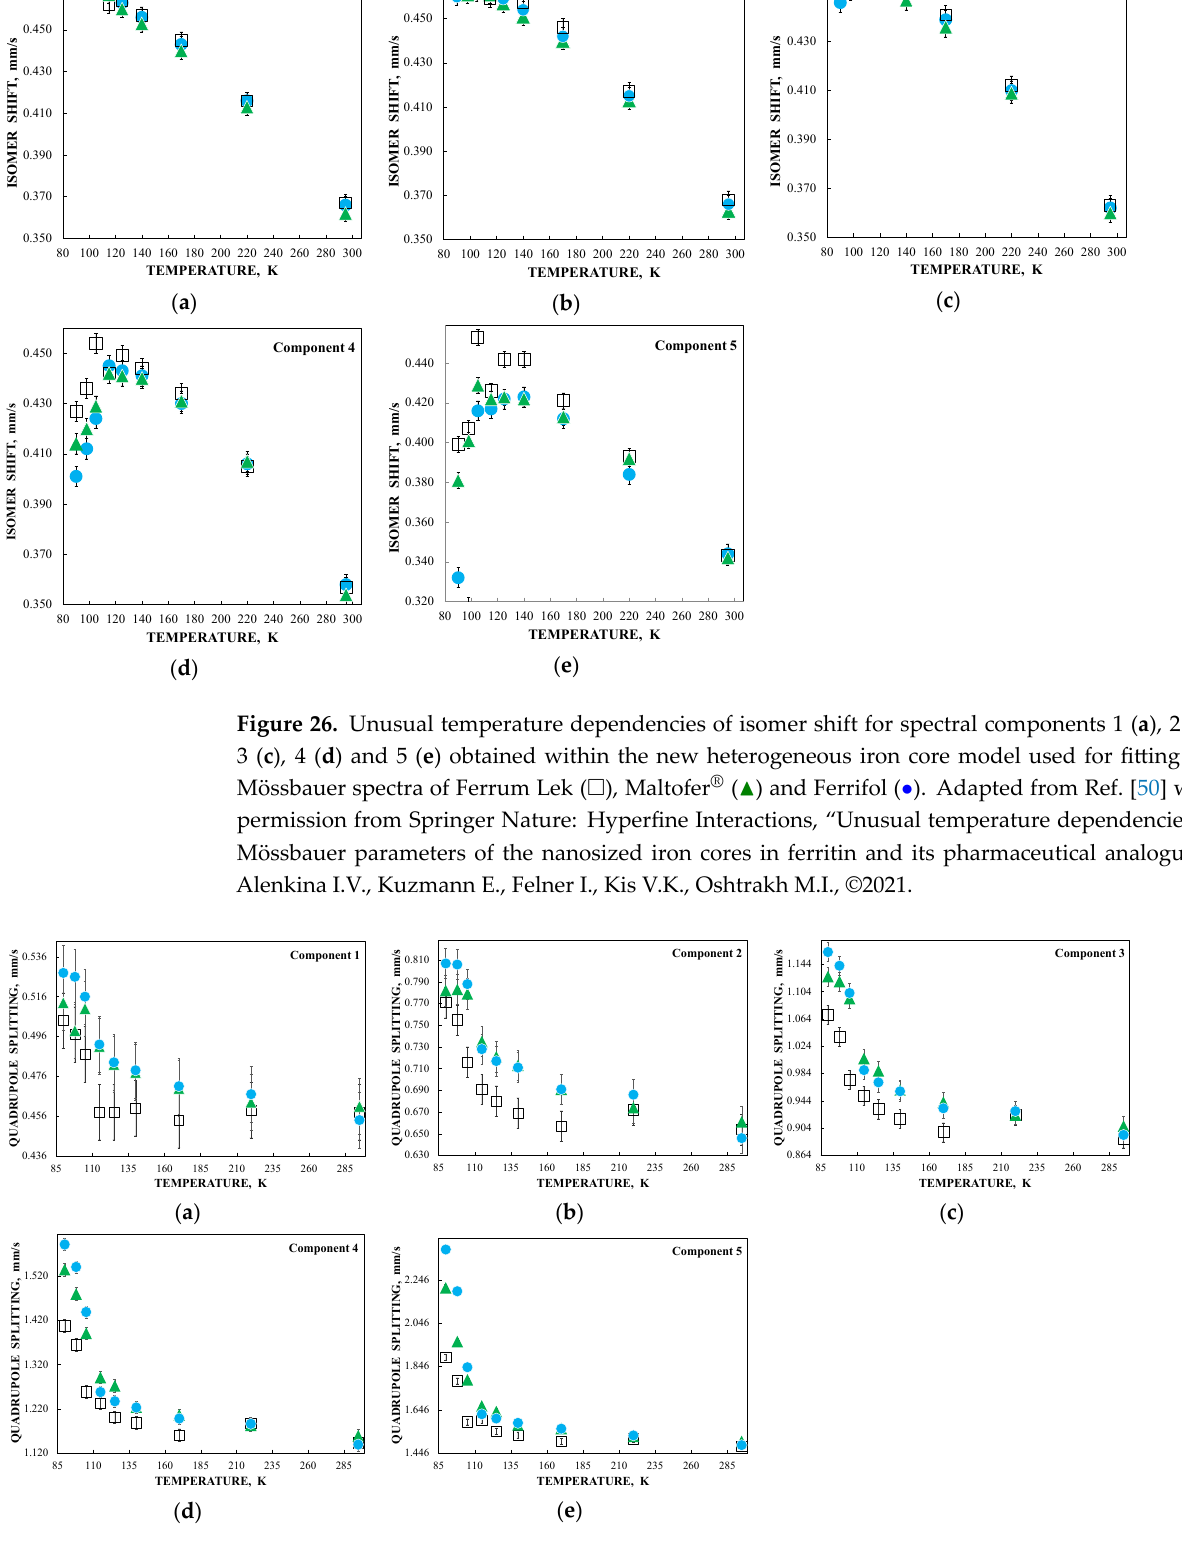
Figure 27. Unusual temperature dependencies of quadrupole splitting for spectral components 1 ( a ), 2 ( b ), 3 ( c ), 4 ( d ) and 5 ( e ) obtained within the new heterogeneous iron core model used for fitting the Mössbauer spectra of Ferrum Lek ( □ ), Maltofer ® ( ▲ ) and Ferrifol ( • ). Data were taken from Refs.